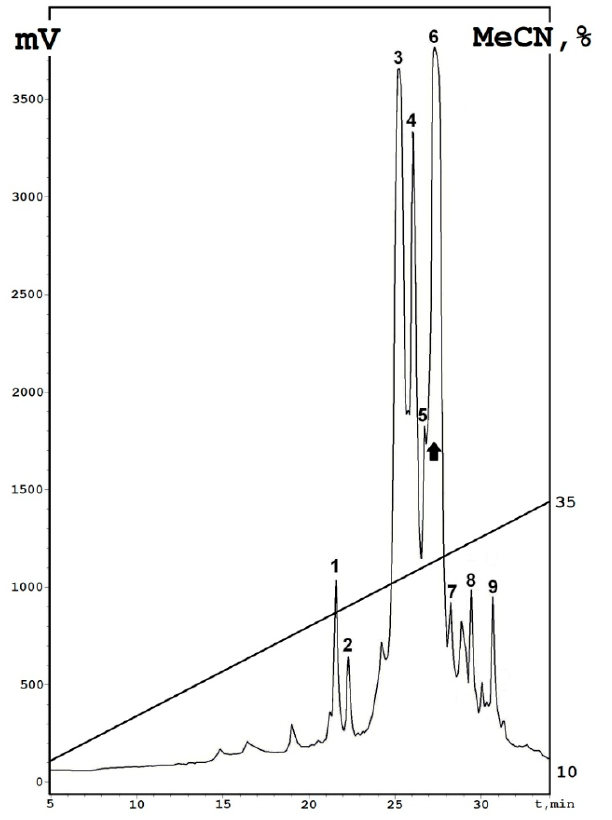
Figure 1. Reversed-phase HPLC (RP-HPLC) profile of 1 M fraction (fraction 4) after affinity chro- matography on a Heparin-Sepharose column, washed with buffer containing 1M NaCl. All collected fractions characterized are indicated by ciphers; a dominant peak is marked by a black arrow. Axis: X—time, min; Y—is a digital signal axis (mAU, milli Absorbance